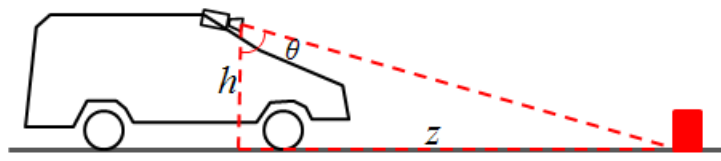
Figure 8. The principle of IPM distance measurement.